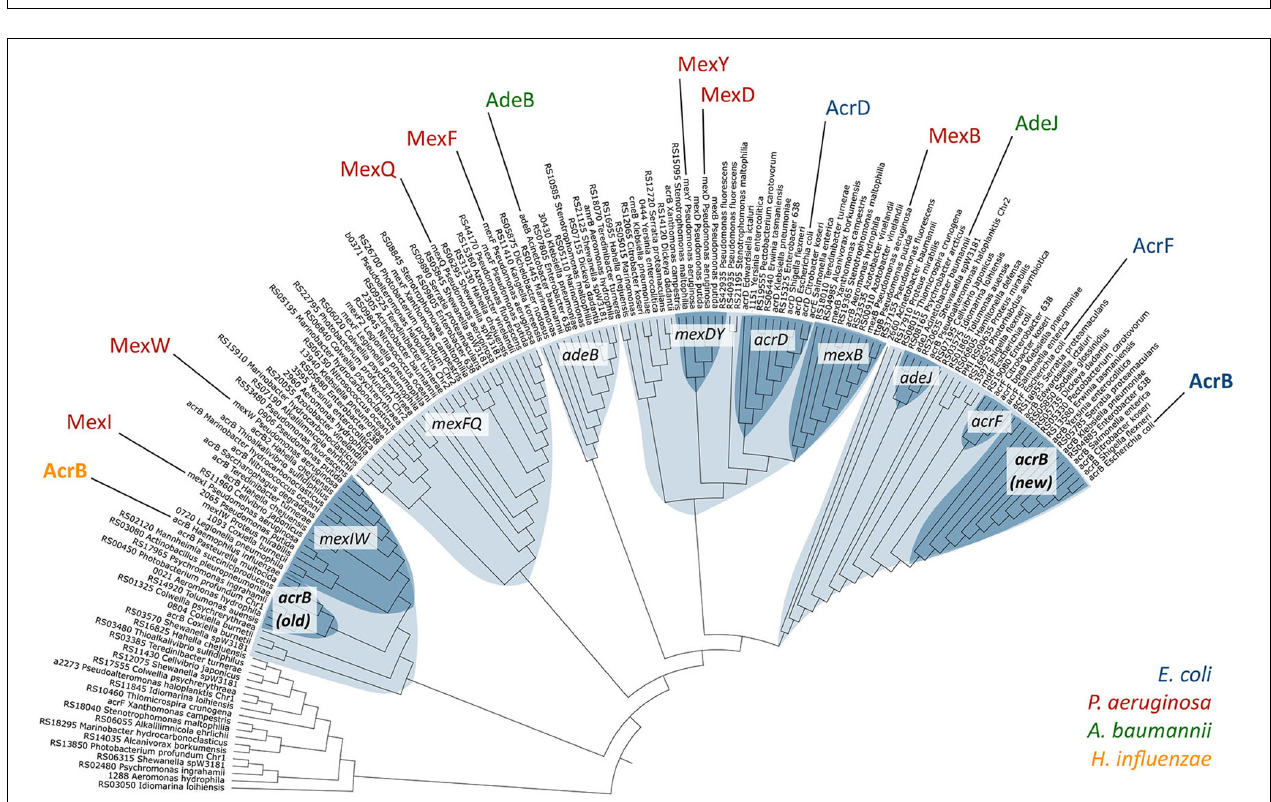
FIGURE 8 | The co-crystal structure of the RamR protein with cholic acid (left) and chenodeoxycholic acid (right). The RamR protein is a dimer that binds to two cholic acid (left) or chenodeoxycholic acid (right) molecules. This binding decreases the DNA binding affinity of the RamR protein, which in turn increasing the expression of RamA, thus promoting the expression of the AcrAB drug efflux system.